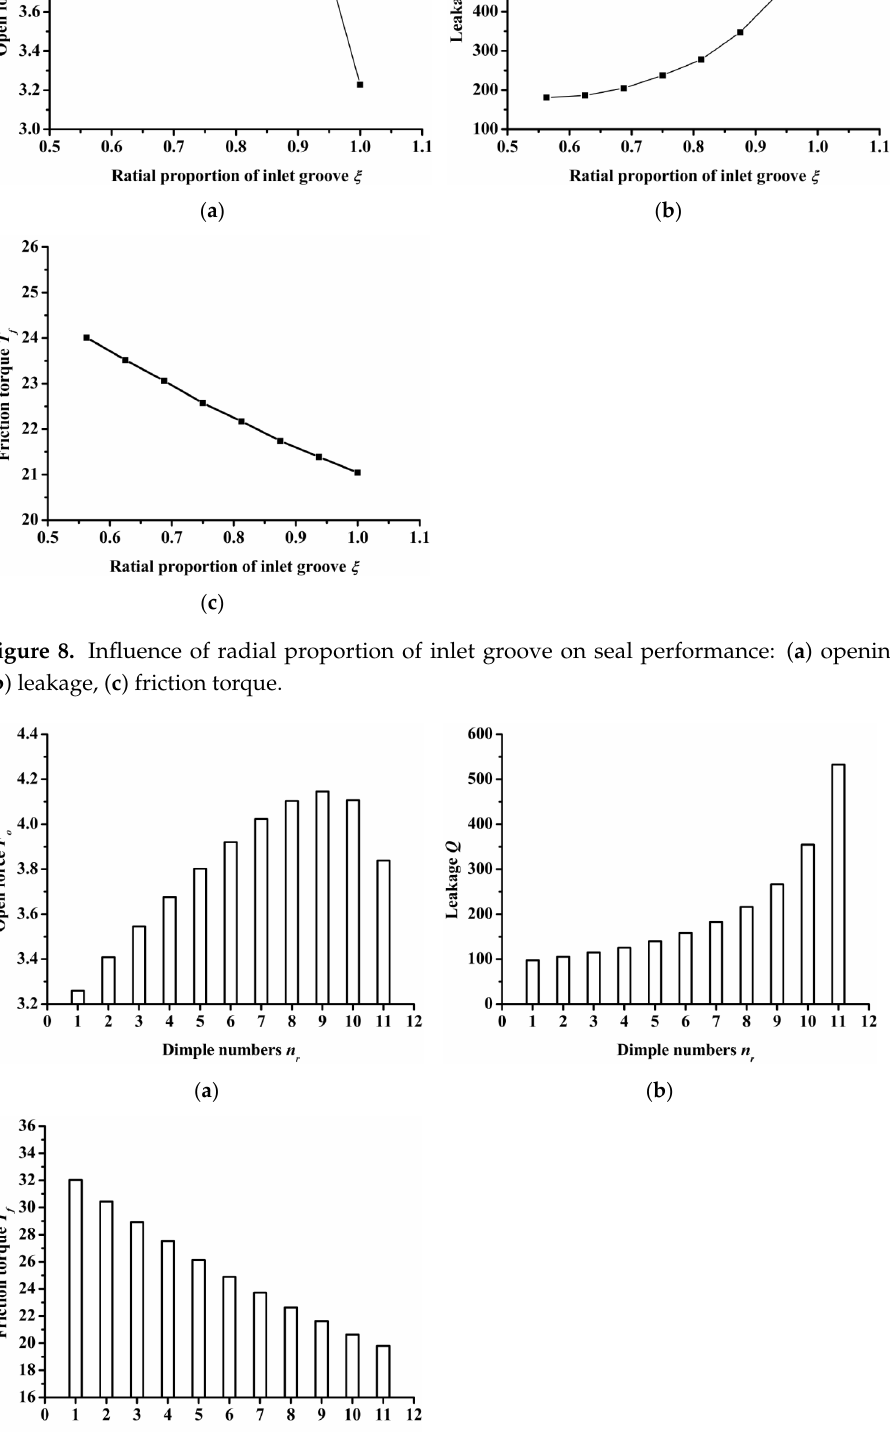
Figure 9. Influence of dimple numbers on seal performance: ( a ) opening force, ( b ) leakage, ( c ) fric- tion torque.